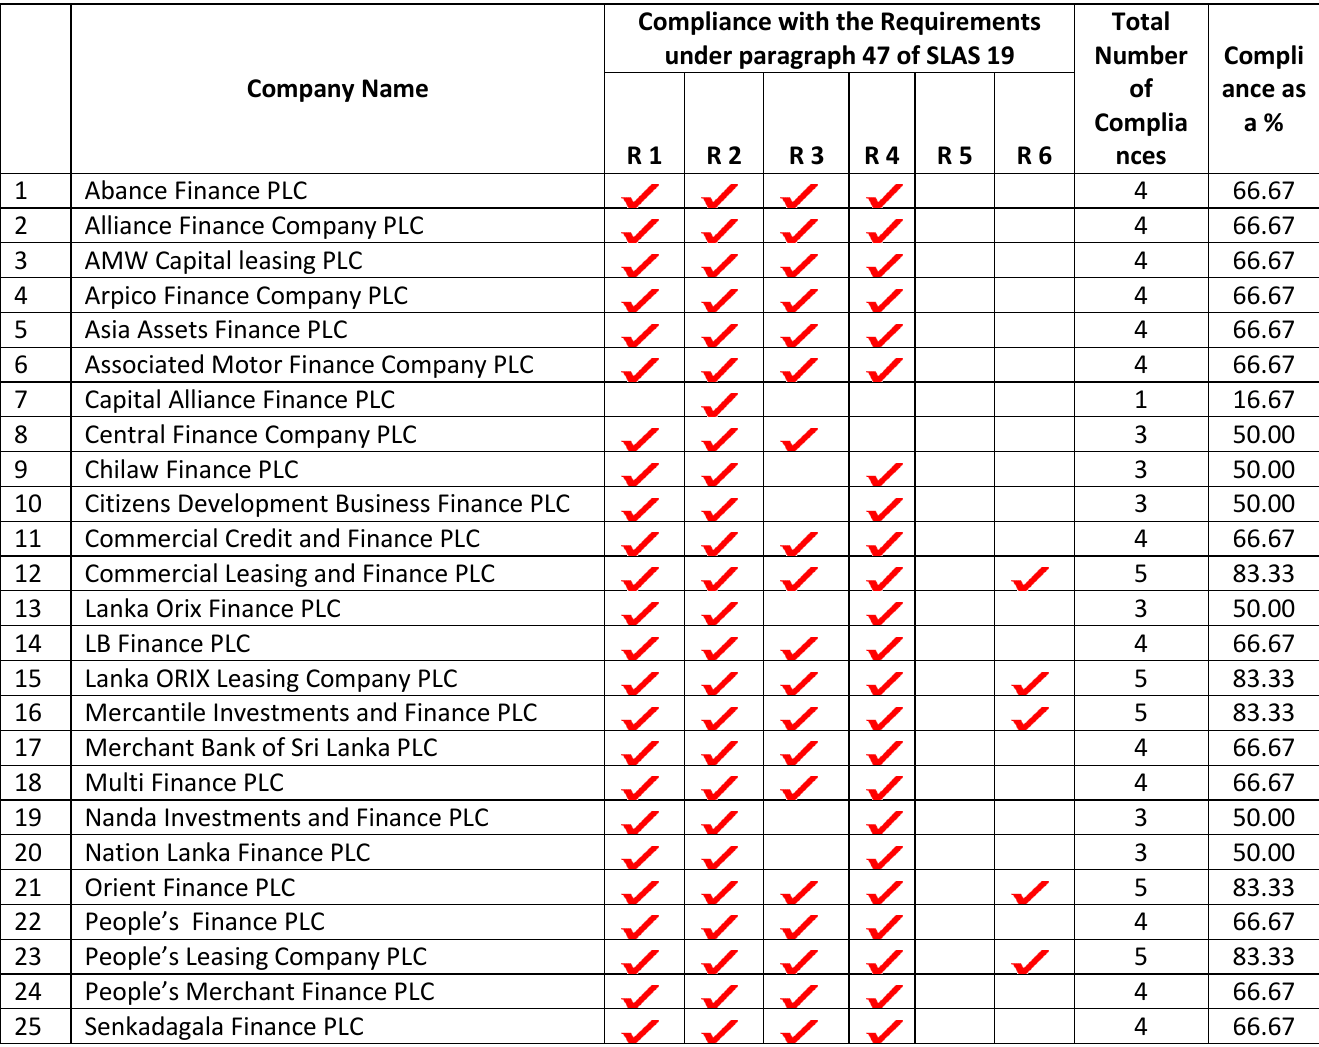
Table 01: Special Evaluation Schedule of compliance for requirements under paragraph 47 of LKAS